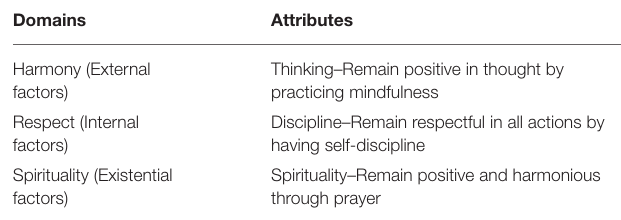
TABLE 2 | Hózhó Resilience Model domains and